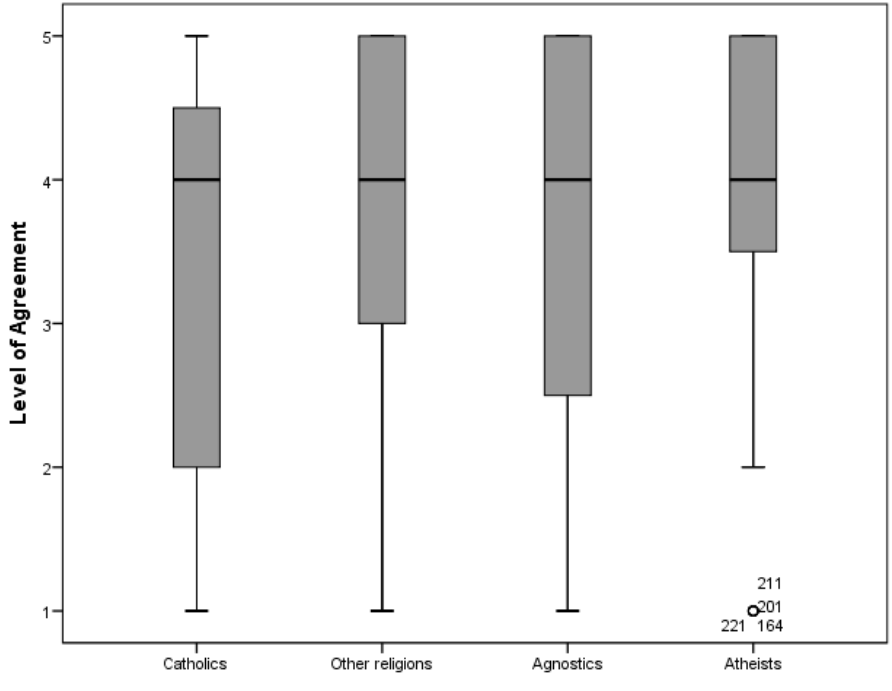
Figure 2. Box ‐ plots showing degree of agreement for different religious groups on banning Figure 2. Box-plots showing degree of agreement for different religious groups on banning pesticides pesticides (numbers indicate outliers). (numbers indicate